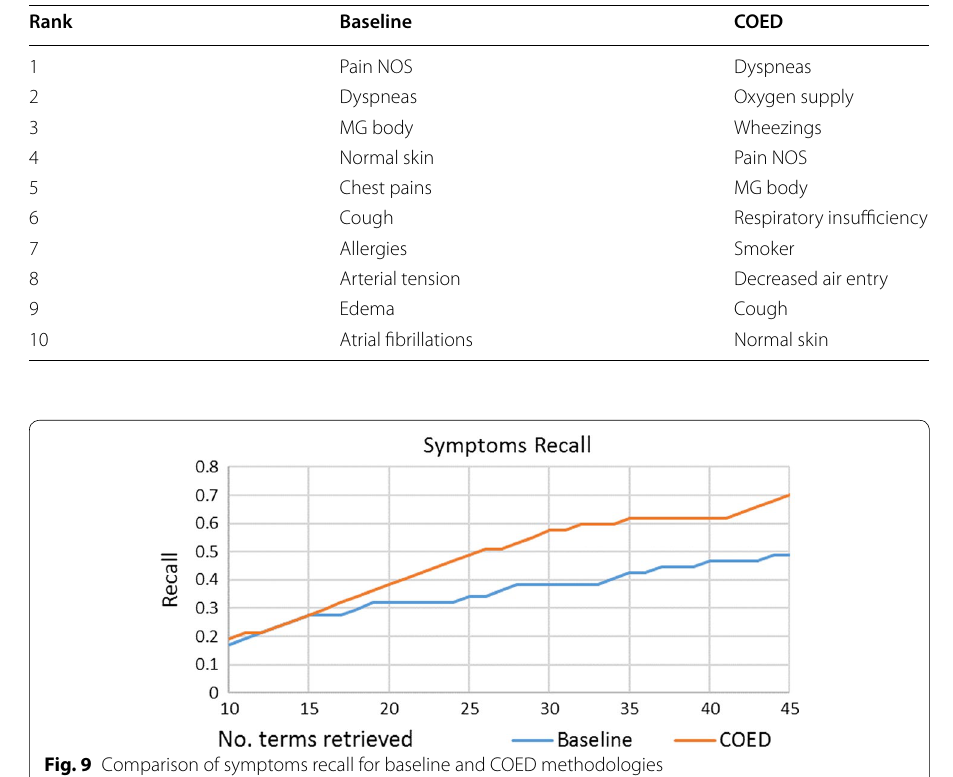
Table 4 Selection of top ten results for symptoms